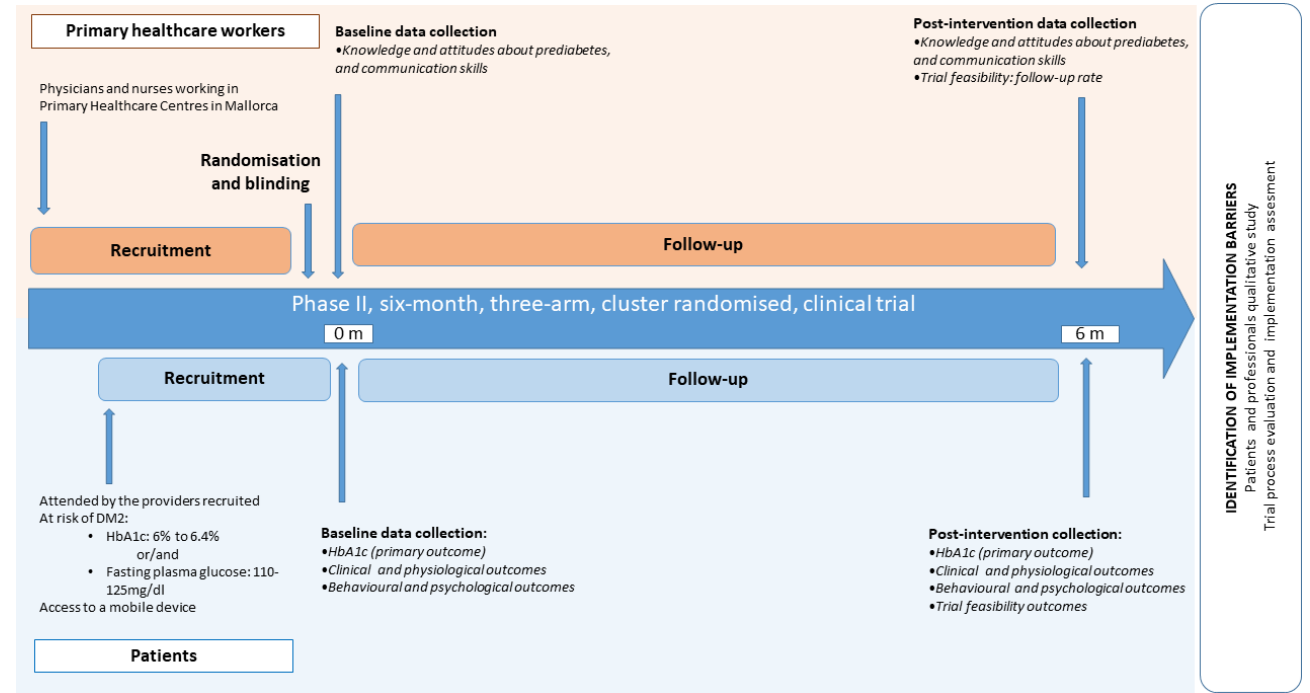
Figure 3. Consort flowchart of the PreDiabeText phase II clinical trial.